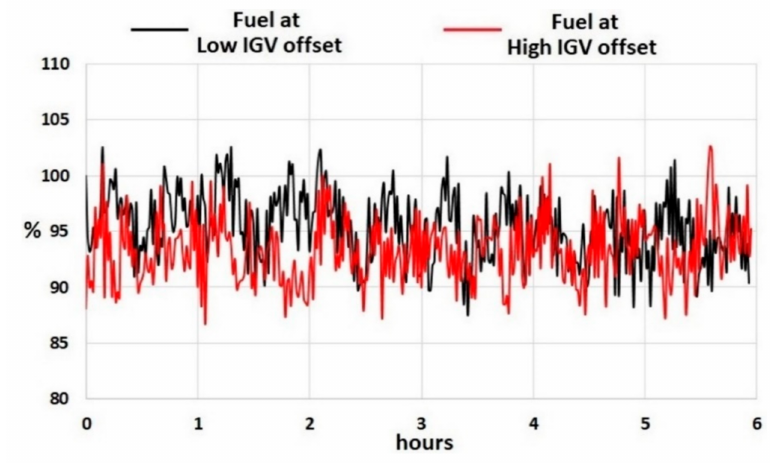
Figure 32. Fuel demand for low and high